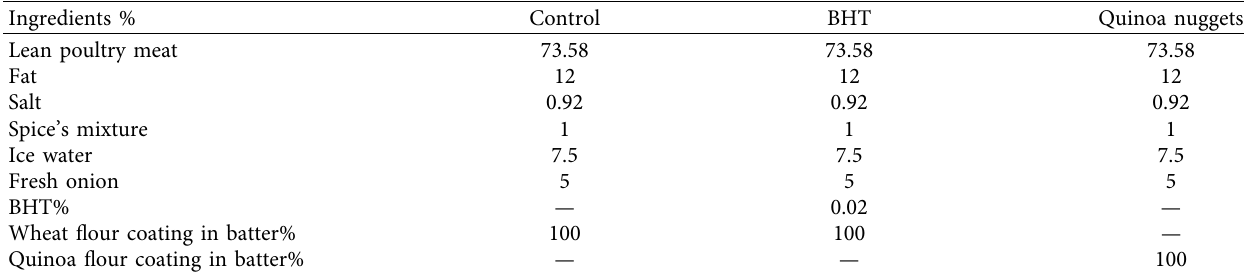
Table 1: Recipe of manufactured chicken nugget